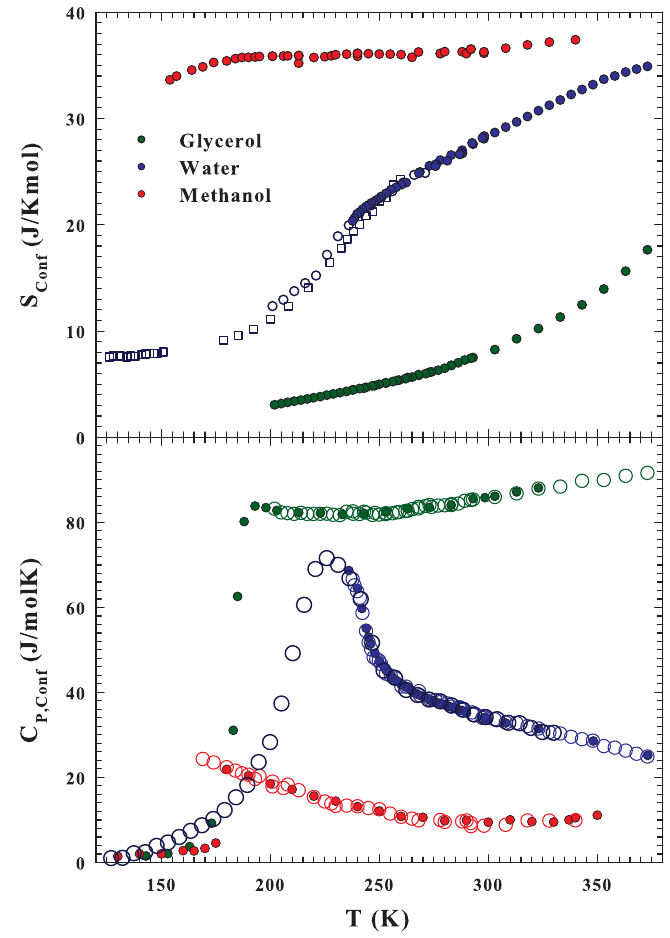
Figure 6. The water configurational entropies S conf ( top side ) and the corresponding specific heat contributions C P , conf ( bottom ) for water, glycerol, and methanol obtained in terms of the Adam–Gibbs model are reported as a function of the temperature. In the water cases, the contributions coming from confined ( circles ) and fused ( squares ) water, which allowed for measurement of the transport functions well inside the supercooled region up to the amorphous phases [22,32,64], are also reported as dark blue open